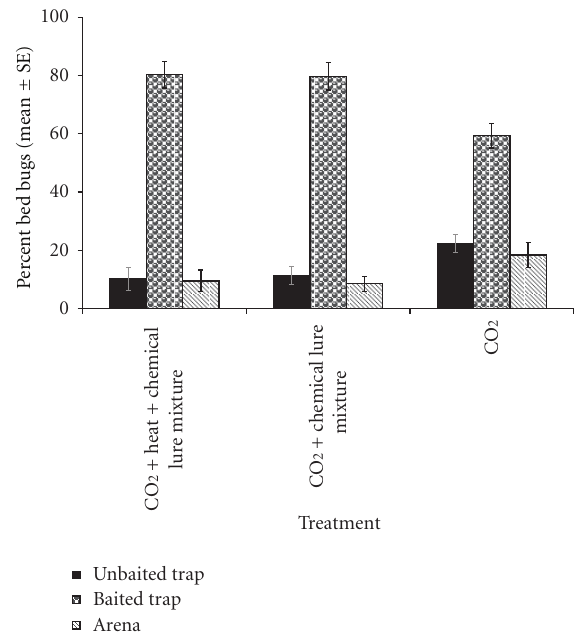
Figure 7: E ff ect of chemical lure mixture and heat + lure mixture when CO 2 is